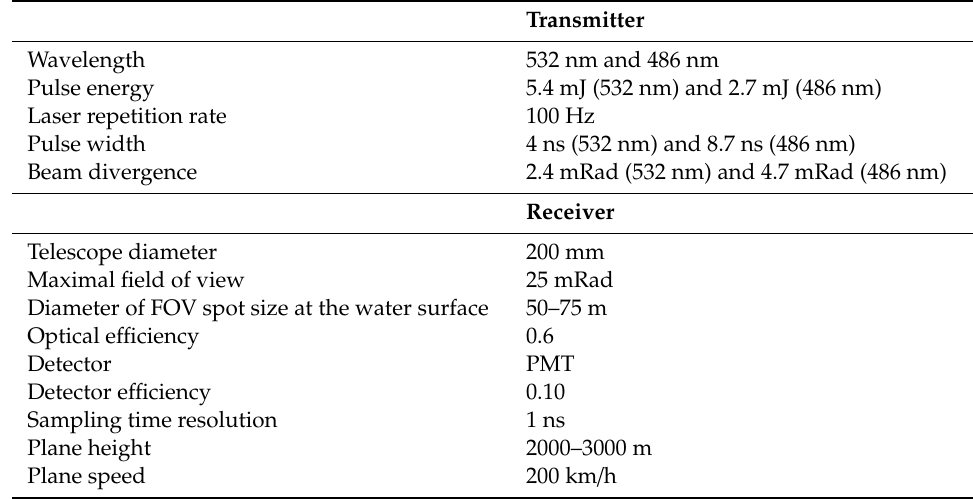
Figure 1. Schematic diagram of the dual-wavelength ocean lidar (DWOL) system. TM—transmitting mirror; AAS—adjustable aperture stop; CL—collimating lens; LDM—long-pass dichroic mirror; FL—focusing lens; PMT—photomultiplier tube; FFC—flexible flat cable. Table 1. Parameters designed for the DWOL system.